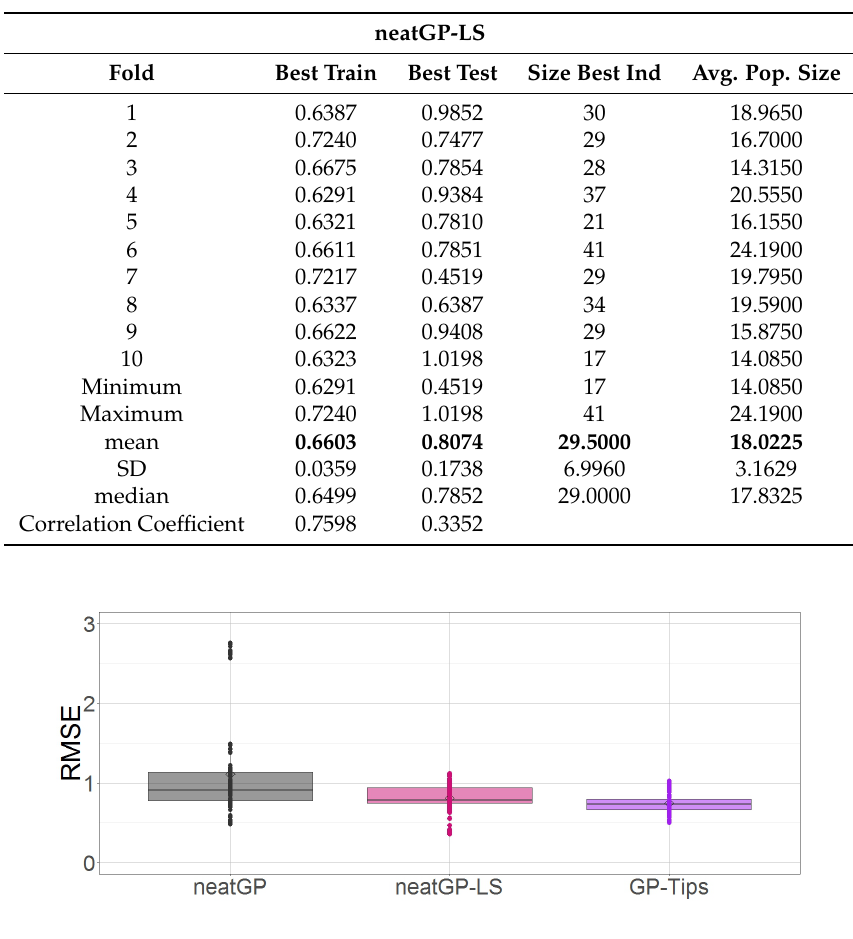
Table 8. RMSE for the 10-fold cross validation performance of neatGP-LS on the 1–4 scale dataset.